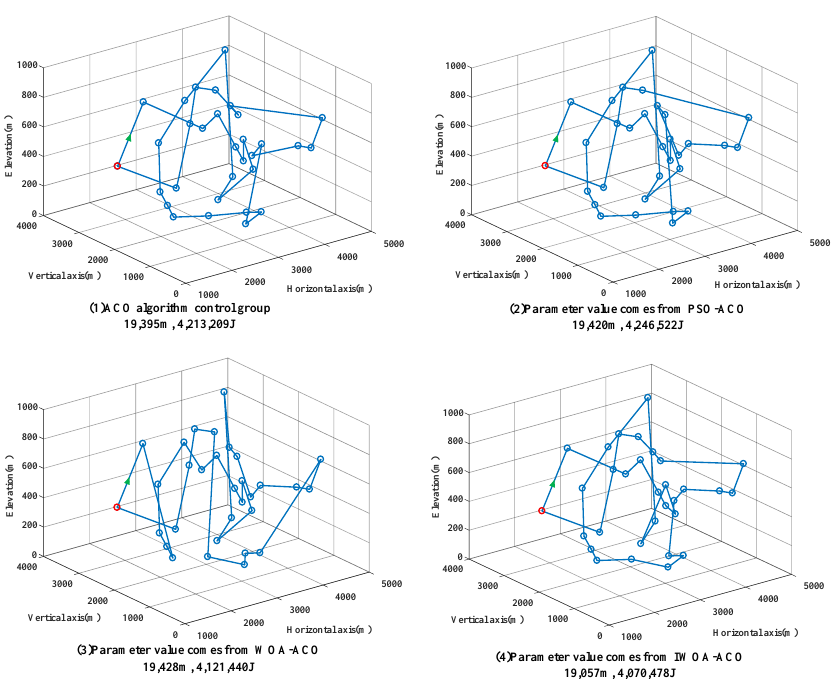
Figure 13. Path planning diagram in the simulation of bump environment. The red node is the starting point, and the green arrow is the travel direction of the electric tractor.